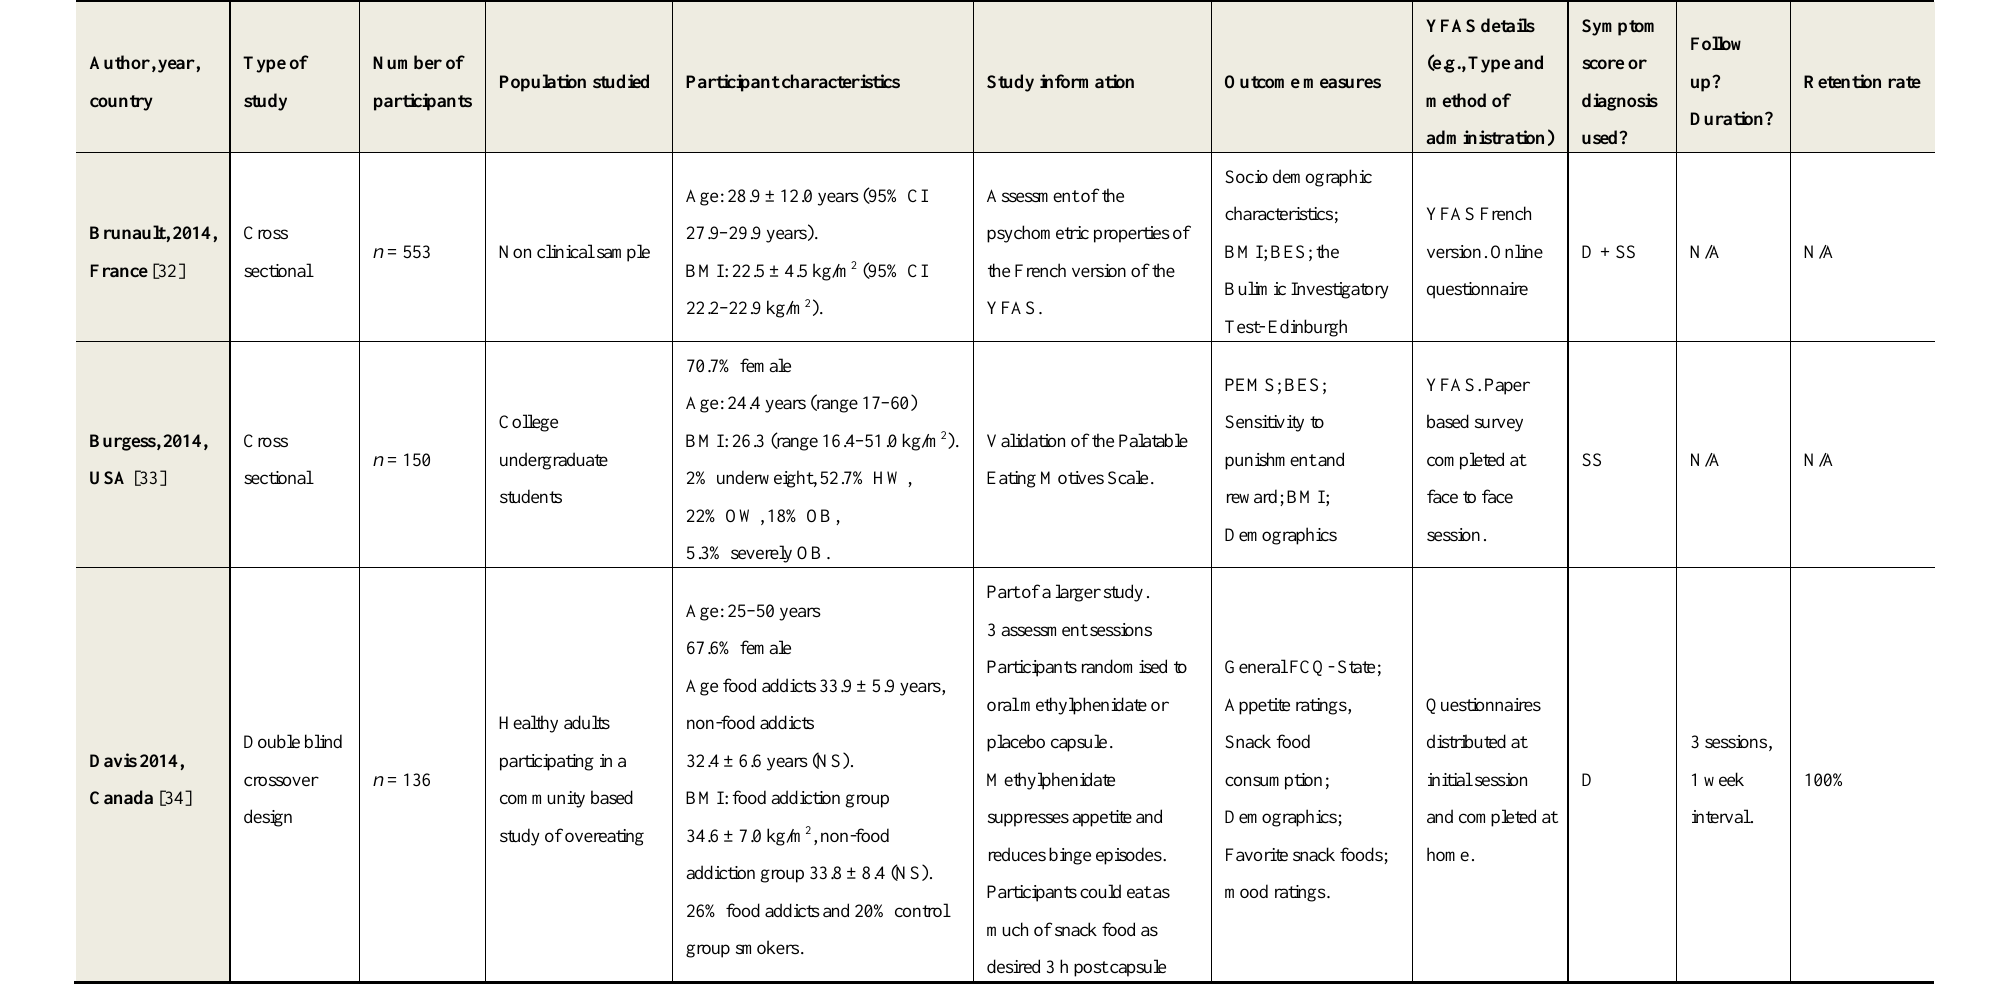
Table 1. Characteristics of included studies using the Yale Food Addiction Scale (YFAS) to assess food